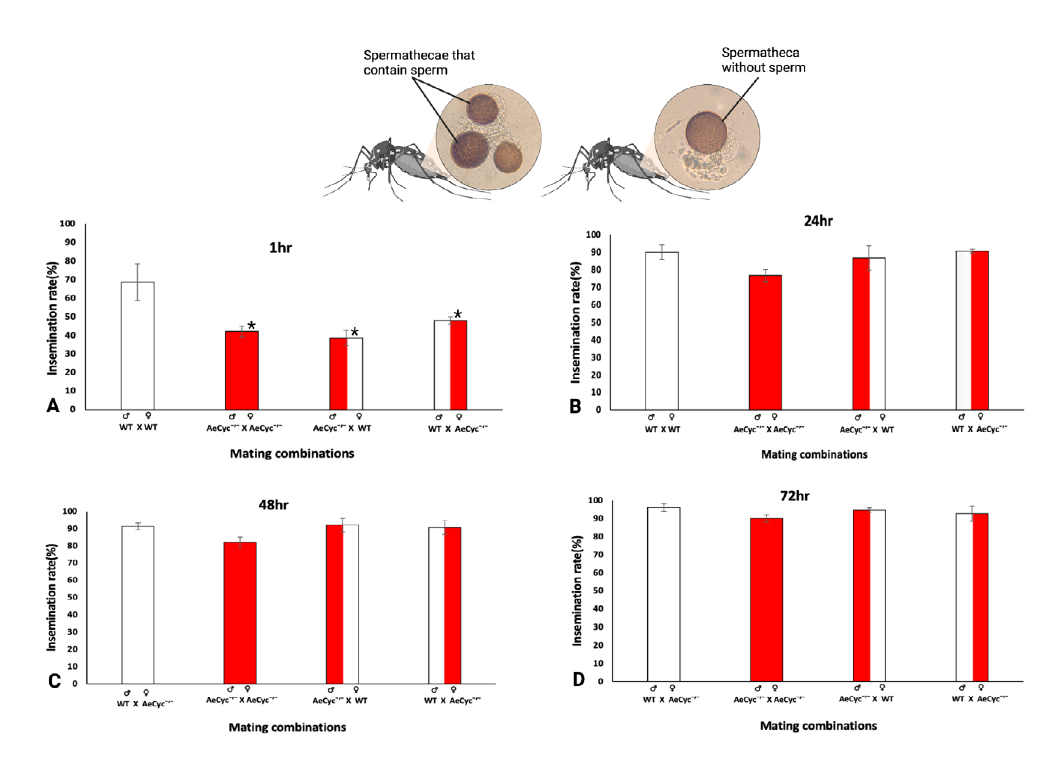
Figure 6. Insemination status of AeCyc −/− ( ♂ & ♀ ) and wildtype ( ♂ & ♀ ) (Nonreciprocal) crossing, and reciprocal crossing groups AeCyc -/ - ♂ and WT ♀ ; AeCyc −/− ♀ and WT ♂ mosquitoes after 1 h ( A ), 24 h ( B ), 48 h ( C ) and 72 h ( D ) of exposure to males for mating (copulation duration). Each value is mean ± SD of three replicates. *Statistically significant p ≤ 0.05.